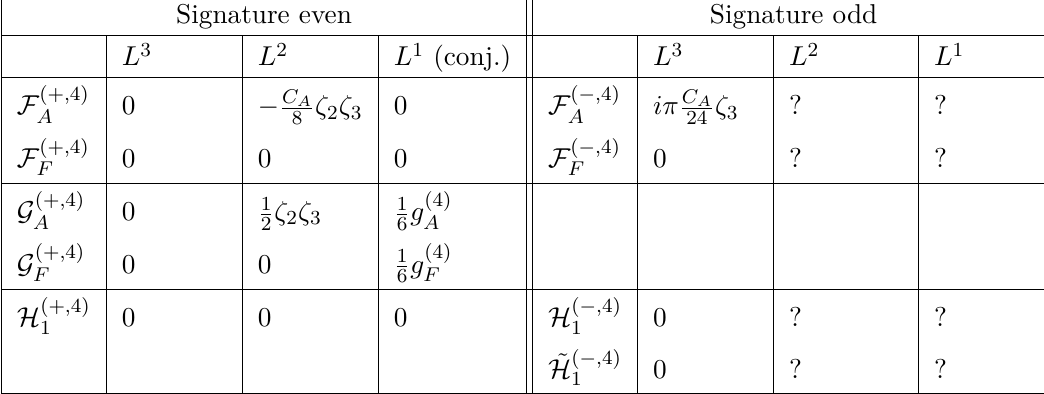
collinear constraint [54] on the same function in eq. (7.34). We stress that these are different kinematic limits. Whereas in the high-energy limit the function G (4) logarithmic contribution — see eq. (7.79a) — in the collinear limit eq. (7.34) forbids any non-linear dependence on the relevant